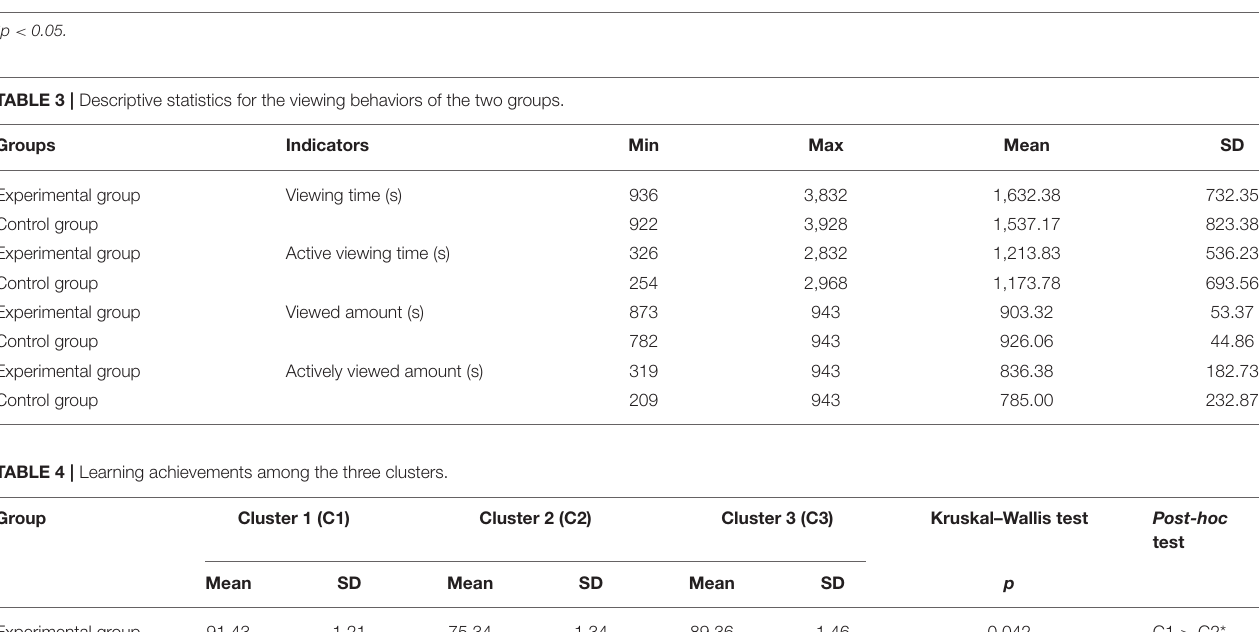
TABLE 2 | Independent-samples t -test of the system user acceptance of the two groups. Group Experimental group